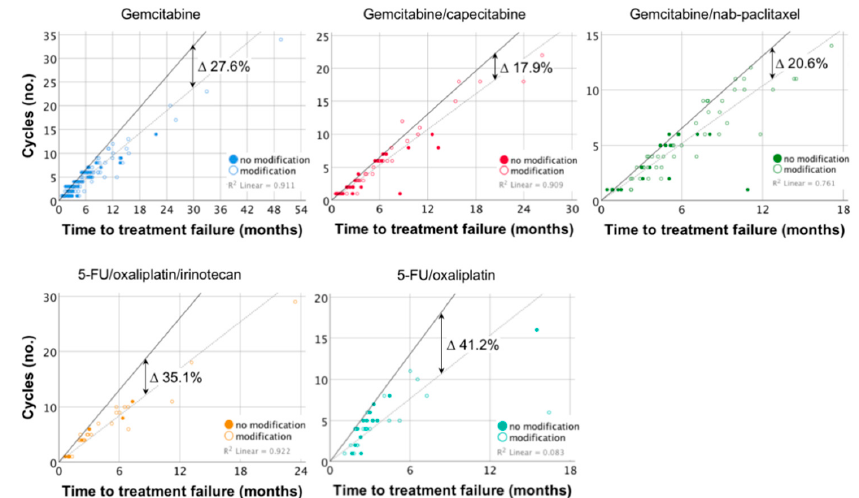
Figure 3. Protocol adherence compared to an ideal treatment schedule according to first-line protocol. The number of administered cycles of chemotherapy was plotted against the TTF for individual patients. Hollow dots indicate protocol modifications. A linear regression model with suppressed intercept was fitted to the plot to illustrate cumulative protocol adherence across each group (dotted line). R 2 indicates the accuracy of the model. The cumulative adherence for each group was determined in relation to the schedule of the respective protocol (solid line) by comparing the slopes of the lines. If patients terminated treatment or died during an ongoing cycle, their data point could occasionally be plotted to the left of the reference line.